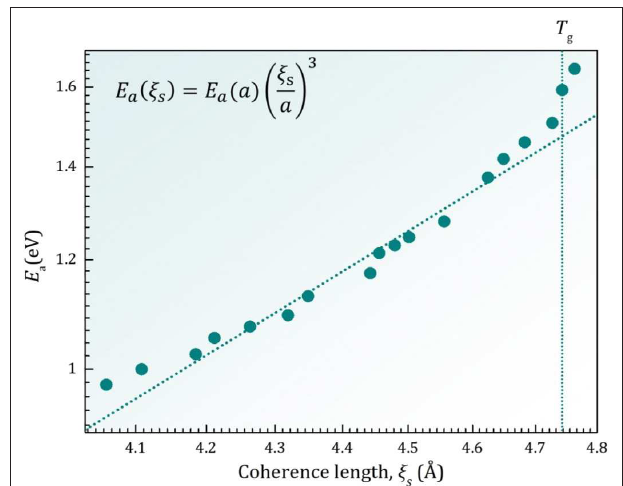
G ( r ) , where G ( r ) 4 π r ρ 0 [ g ( r ) – 1], for = 573K) [ 18]. (cid:12) (cid:12) = (cid:12) (cid:12)